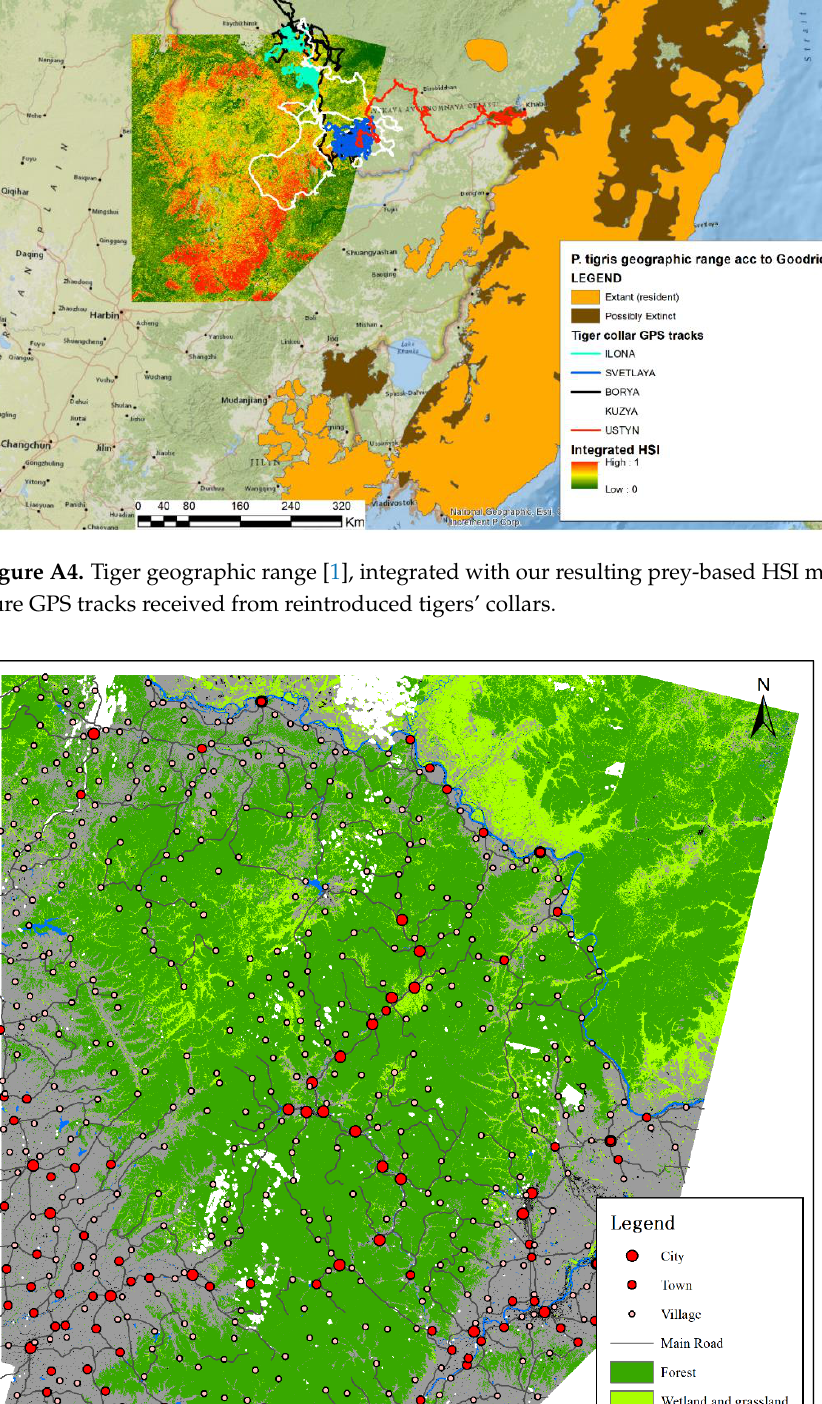
Animals. 2022 , x , 30 of 37 Figure A2. ( A ) Integrated prey-based MaxEnt model based on the Lesser Khingan winter track census survey, ( B ) MaxEnt model based on data from GPS-collars on tigers. Figure A3. Combining the results and regional zoning schemes. ( A ) Orographic diagram of the basin of Amur River (Heilongjiang) [55] and potential corridors calculated using the least cost method. Symbols on the map A: 1 — mountain ranges and systems of ridges, 2 — plains. ( B ) Floristic areas of Northeast China [85] and tiger GPS tracks (l ines of different colors marked with the tigers’ names Ilona, Svetlaya, Kuzya, Borya, Ustin [3]); designations on map B: 1 — Manchurian mixed forests, 2 — Ussuri broadleaved and mixed forests, 3 — Amur wetland and wet steppes, 4 — Ussuri wetlands and forest-steppes. Green circles indicate regions with potentially important green corridors of level 1.